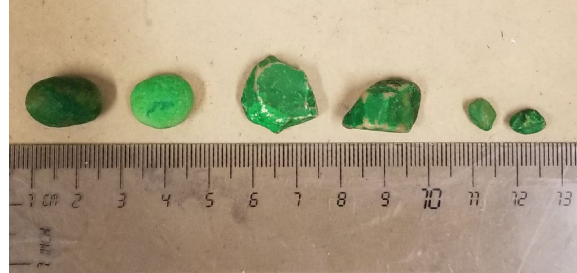
Figure 3. Representative samples of natural rounded particles (left), natural angular particles (center), and natural small particles of mixed angularity (right) used in experiments. Particles were hand selected, and care was taken to avoid picking only the “prettiest”, most-well-shaped particles. Glass marbles, of similar size to the rounded and angular particle groups, are not